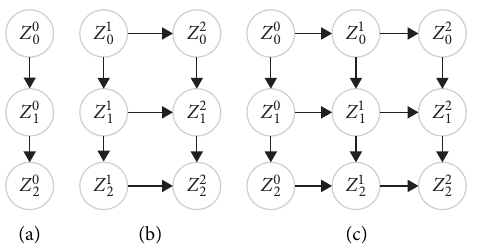
Figure 1: Example of a dynamic Bayesian network. (a) B